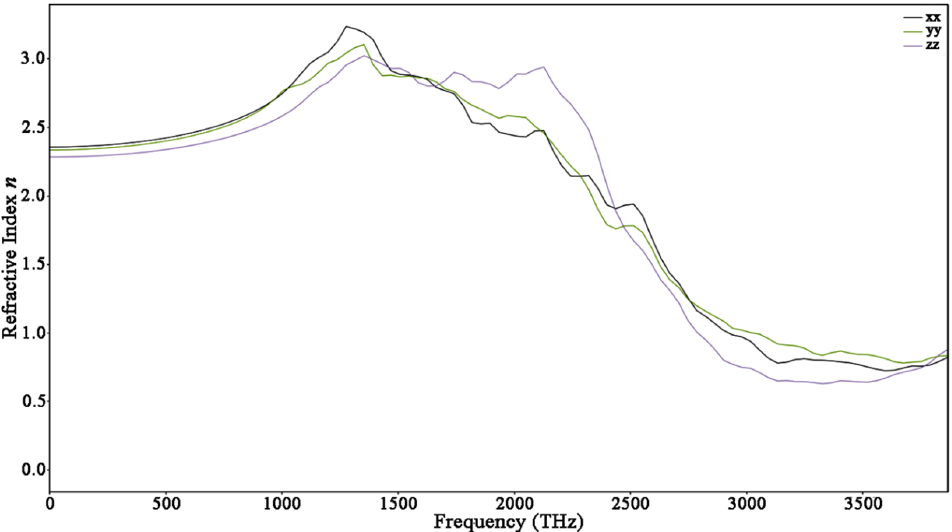
Figure 7. Calculated refractive index for m-HfO 2 in function of frequency.